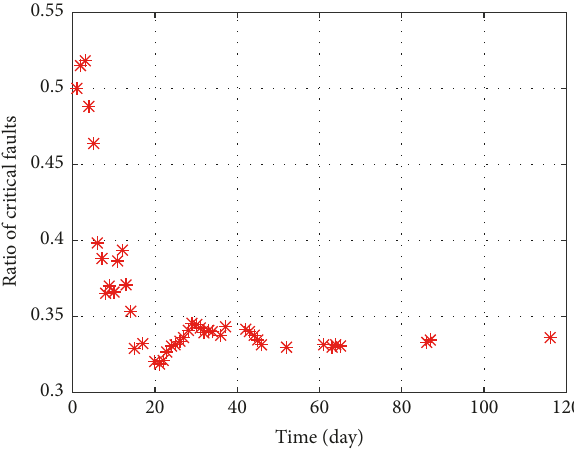
Figure 6: Ratio of critical faults to total accumulated